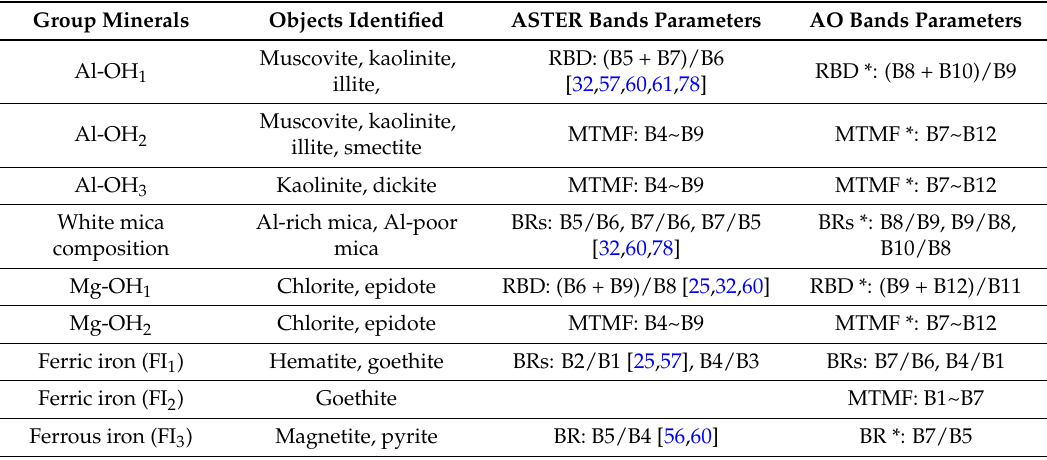
Table 4. The BRs, RBDs and MTMF parameters used in the